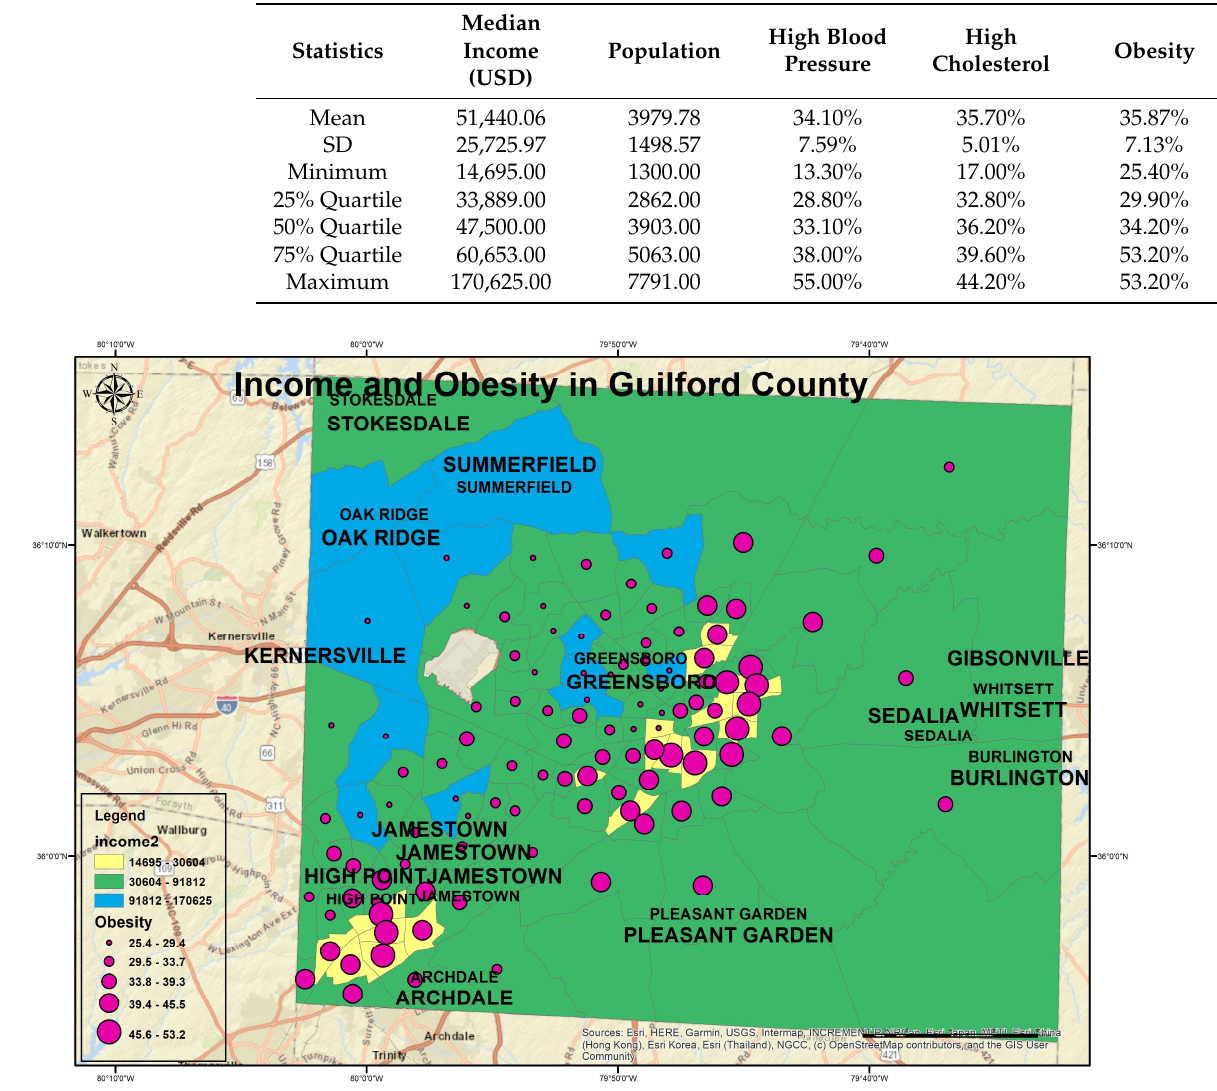
Figure 5. Income and obesity in Guilford County. Figure 5.